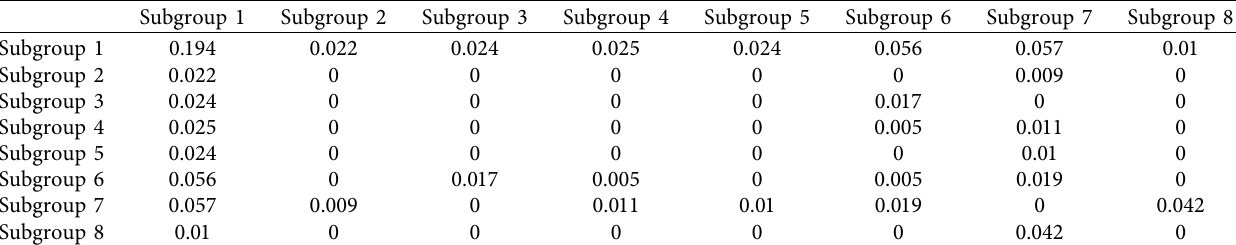
Table 7: Density of